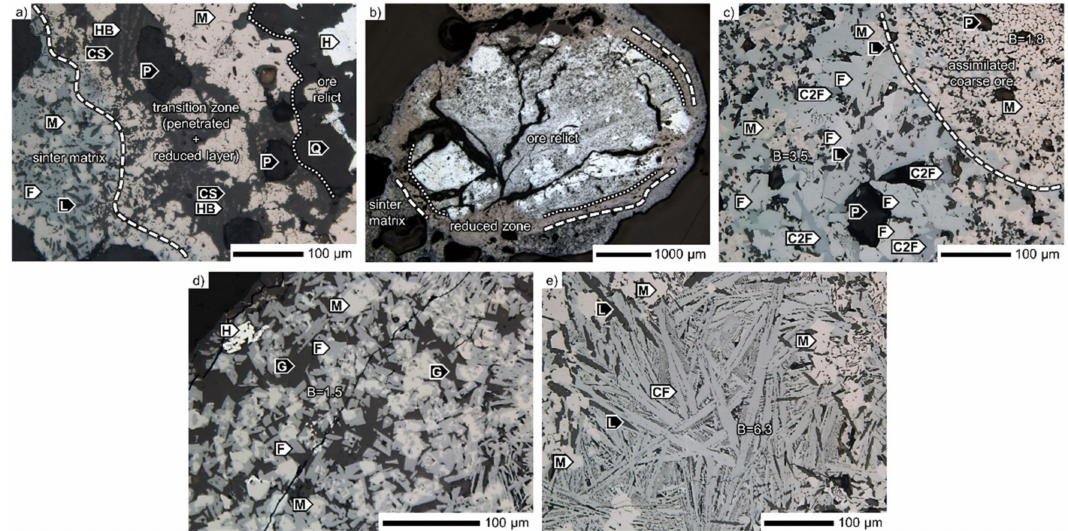
Figure 13. Reflected light micrographs of the SM-S sinter. B: CaO/SiO 2 , CF: monocalcium ferrite, CS: pseudowollatonite, C2F: dicalcium ferrite, F: SFCA, G: glass, H: hematite, L: larnite, M: magnetite, P: pore, Q: quartz. Table 8. Average chemical composition of the secondary phases in the SM-S sinter, wt %.